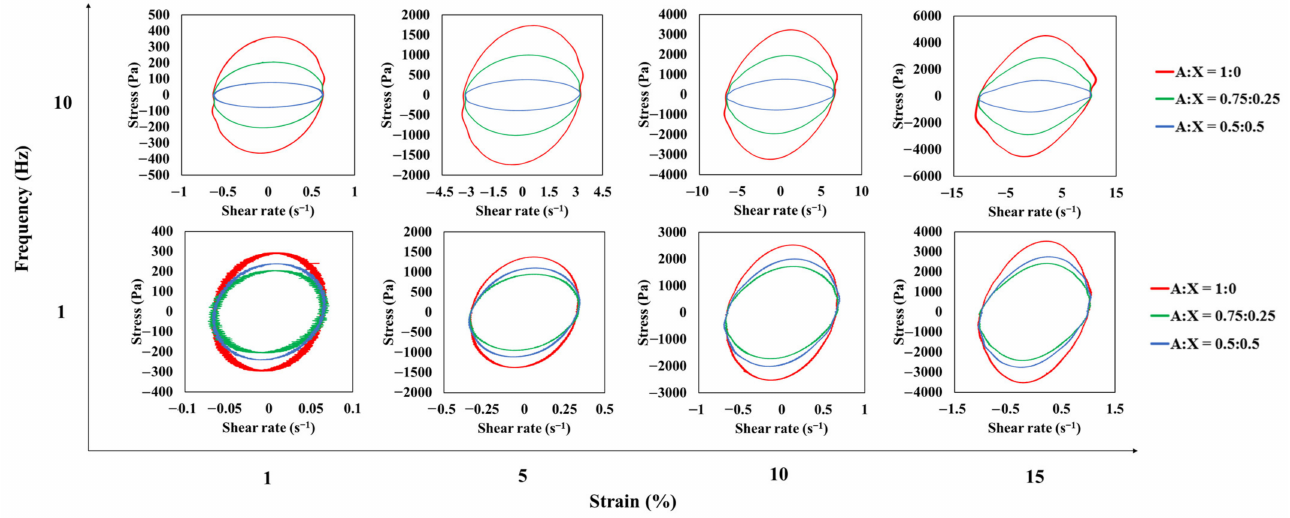
Figure 7. Viscous Lissajous-Bowditch curves for agarose-xanthan gel systems measured at different strains and